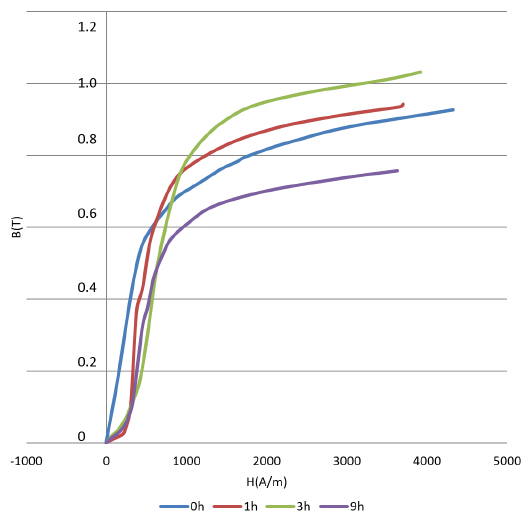
Figure 9. Magnetization curve (AC Permeability) of the ferrous alloy with different milling